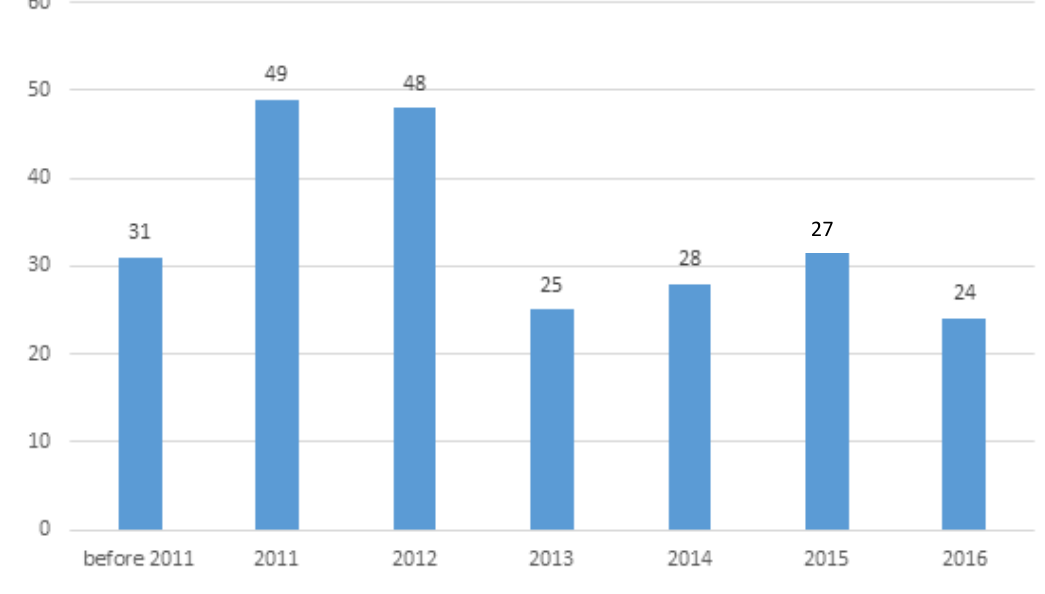
Figure 3. The number of courses added in NTU OCW each year.